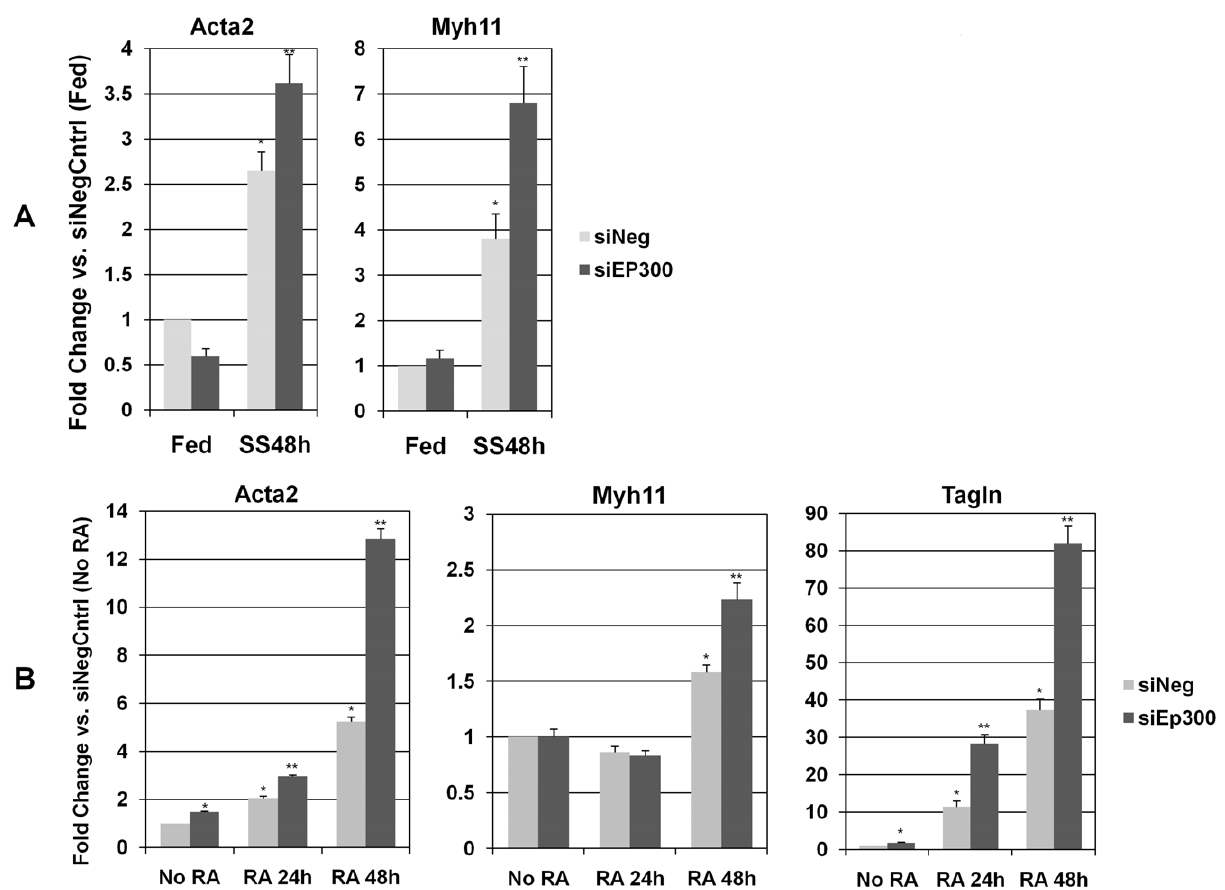
Figure 10. p300 siRNA knockdown and human SMC differentiation markers. A . Human CASMC were transfected with either scrambled negative control siRNA (siNeg) or with a transcript targeting EP300 (siEP300), and then either serum fed (Fed) or serum starved for 48 hours (SS48). Resulting qRT-PCR expression values were normalized to control (Fed cells transfected with siNeg). * = significantly (p , 0.05) different from control. ** = significantly (p , 0.05) different from control and from siNeg time-matched controls. B . A404 cells were transfected with either scrambled negative control siRNA (siNeg) or with a transcript targeting Ep300 (siEp300), and then treated with retinoic acid for 24 (RA 24 h) or 48 hours (RA 48 h), or left untreated (No RA). Resulting qRT-PCR expression values were normalized to control (No RA cells, transfected with siNeg). * = significantly (p , 0.05) different from control. ** = significantly (p , 0.05) different from control and from siNeg time-matched controls.